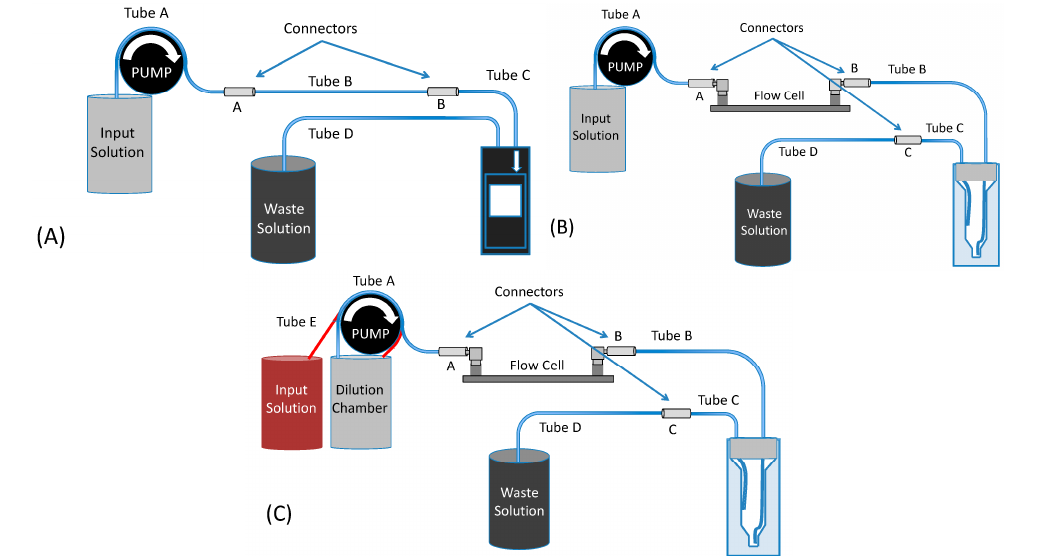
Figure 2. Flow system design. ( A ) The input solution is pumped through Tube A (length l = 39 cm, diameter d = 0.5 mm), through Tubes B ( l = 22.5 cm, d = 1.0 mm) and C ( l = 10 cm, d = 1.0 mm), and into